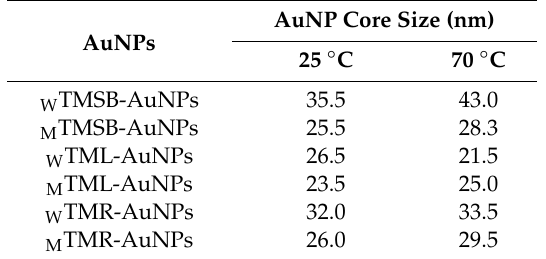
Figure 3. HRTEM analysis of shape and size distribution of M TMSB-AuNPs synthesized ( A ) at 25 °C and ( B ) 70 °C. Table 4. Core sizes of TM-AuNPs were analyzed by HRTEM.